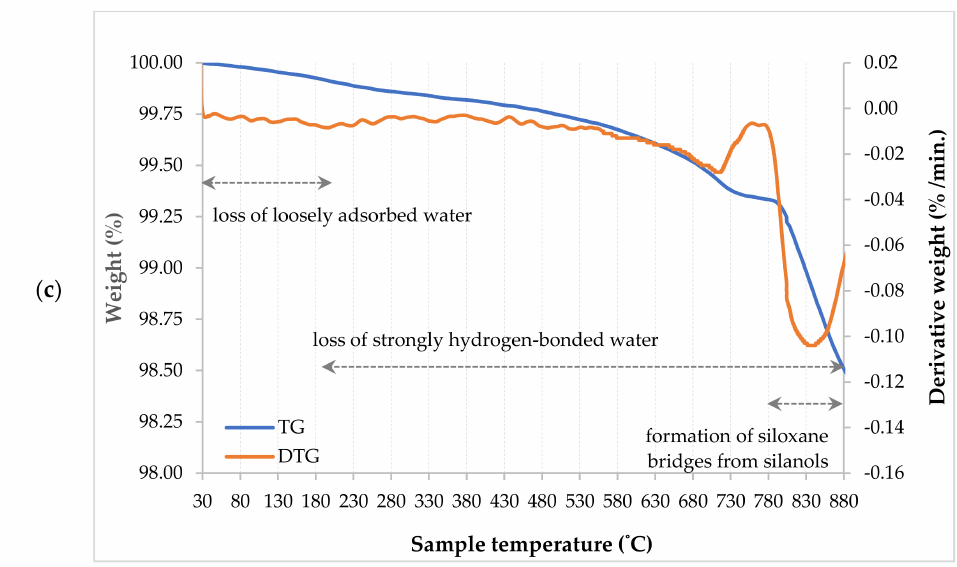
Figure 1. Thermogravimetric trace (30–880 ◦ C) for ( a ) Fuji IX glass; ( b ) Kavitan Plus glass;